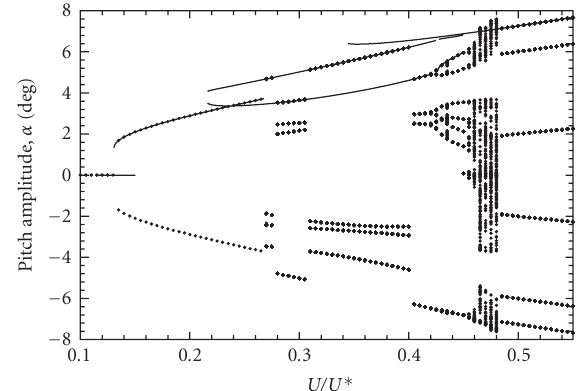
Figure 7: Comparison of the bifurcation diagrams obtained via the defect-controlled method and AUTO; • , defect-controlled results; —, AUTO (stable